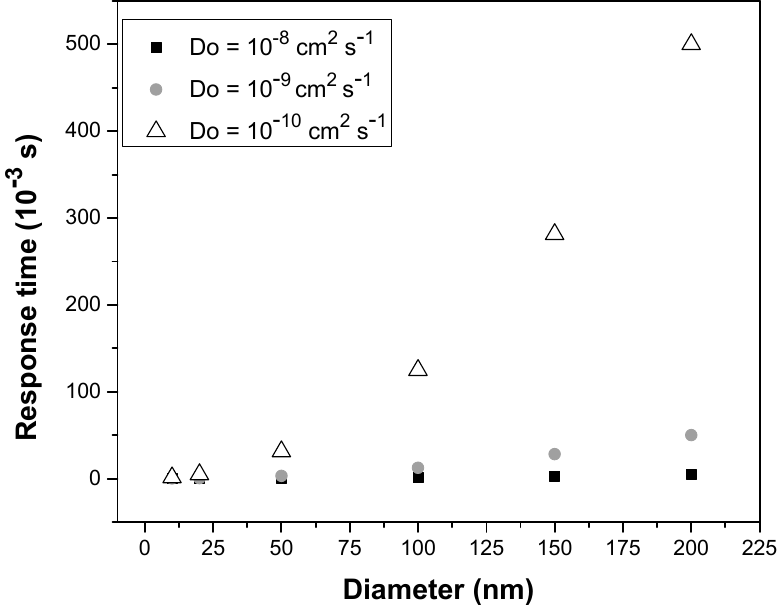
Figure 3. Calculated diffusional response time of nanospheres/nanocylinders as a function the diameter of the object.